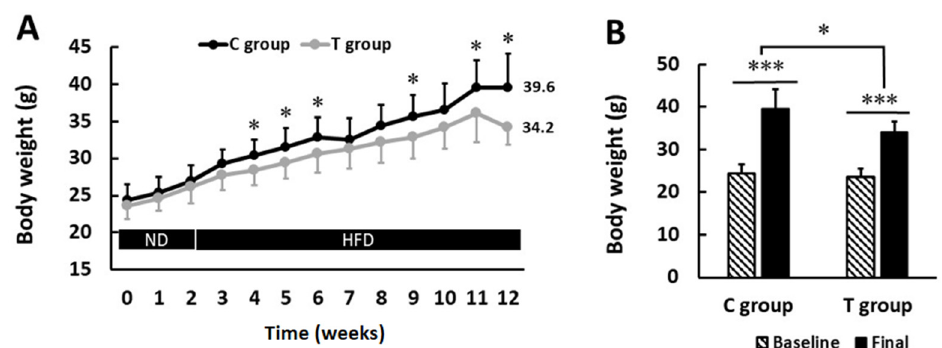
Figure 2. Body weight (BW) progression and BW gain during the intervention. ( A ) Statistically significant differences were found between experimental groups at 4, 5, 6, 9, 11, and 12 weeks ( p < 0.05). ( B ) BW gain was statistically significant in both C group and T group ( p < 0.05). Values are expressed as mean ± SD. HFD: high-fat diet; ND: normal diet. * p < 0.05, *** p < 0.001.